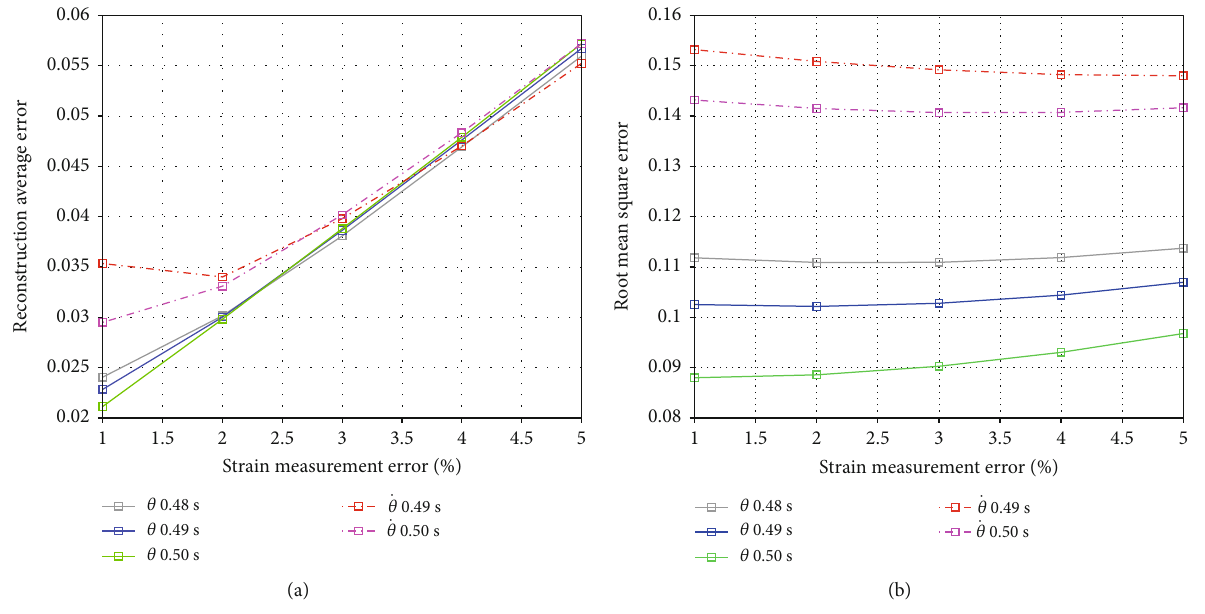
Figure 12: Reconstruction error varies with strain measurement error at 0.5, 0.49, and 0.48s.